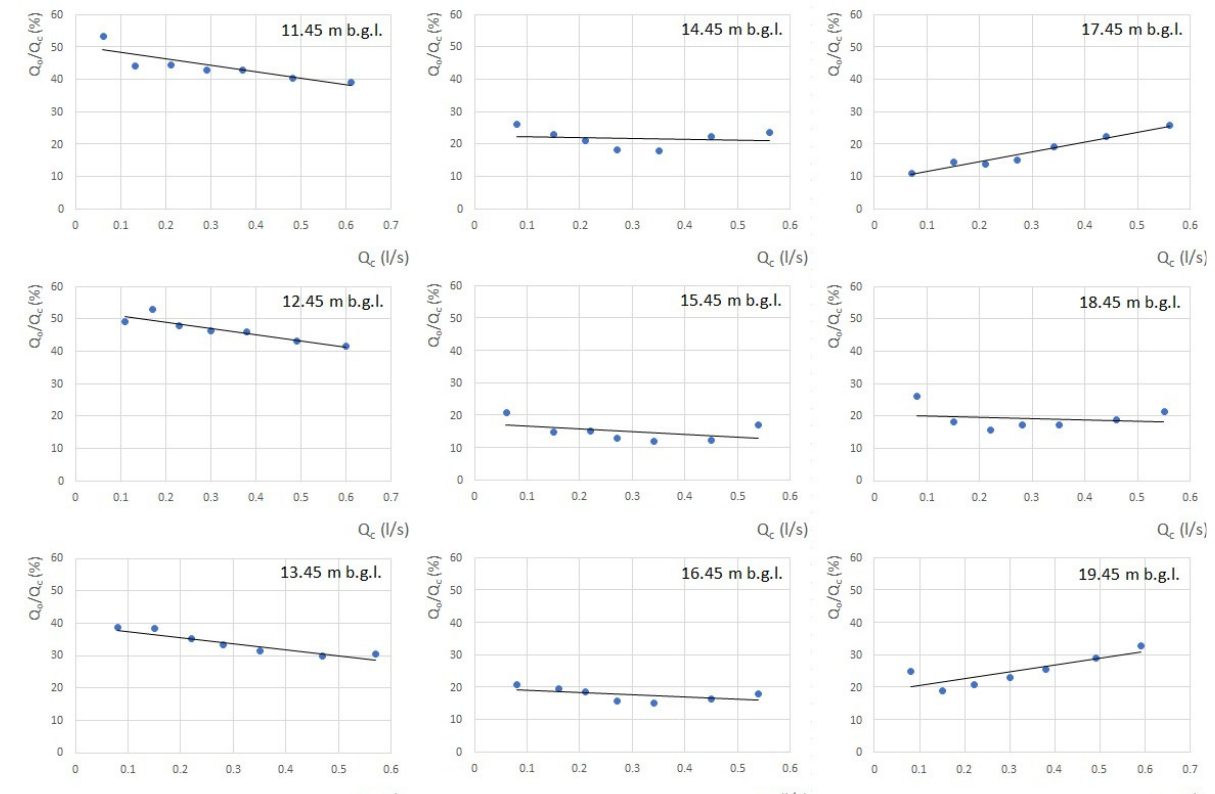
Figure 12. Pilot test on the HJ-3 extraction well on 28 July 2020—measurements at various depth levels.